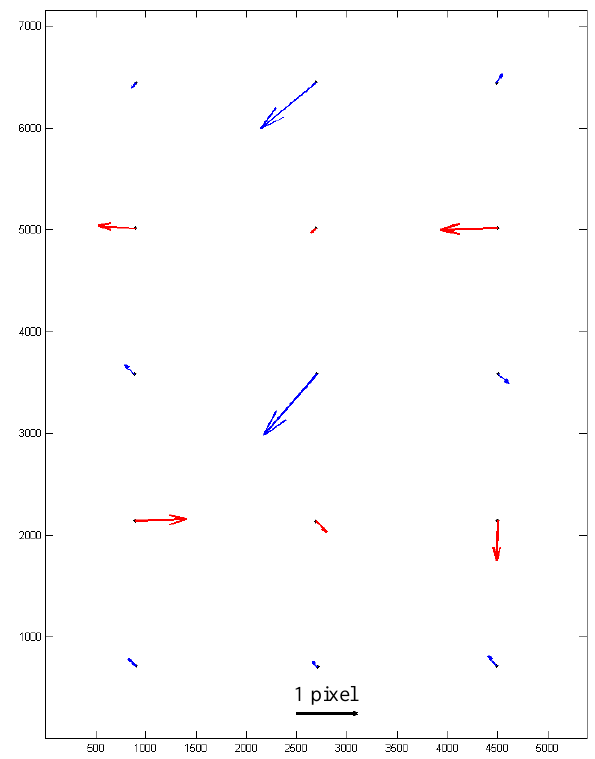
Figure 7. Error vectors for control points (blue) and checkpoints (red) from the intensity-based method